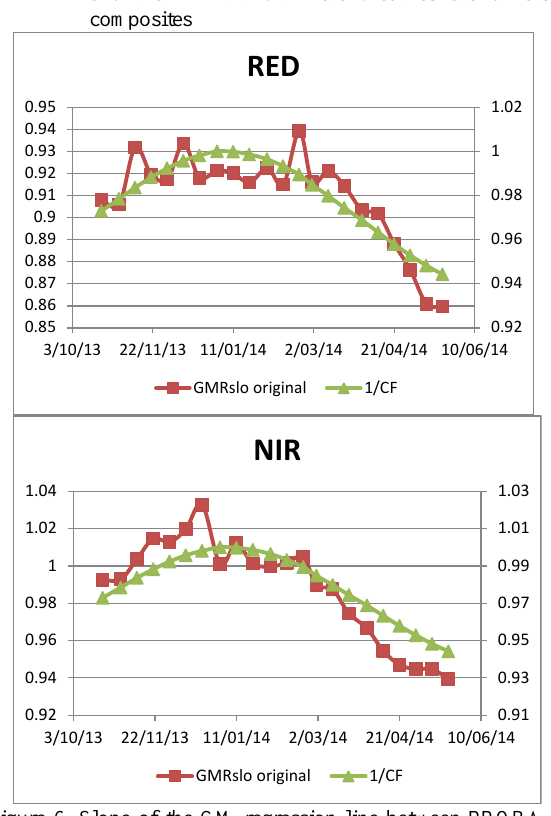
Figure 6. Slope of the GM regression line between PROBA-V and VGT2 RED (left) and NIR (right) reflectances for the overlapping period (left Y-axis), superimposed with the shape of the correction function for d² (right